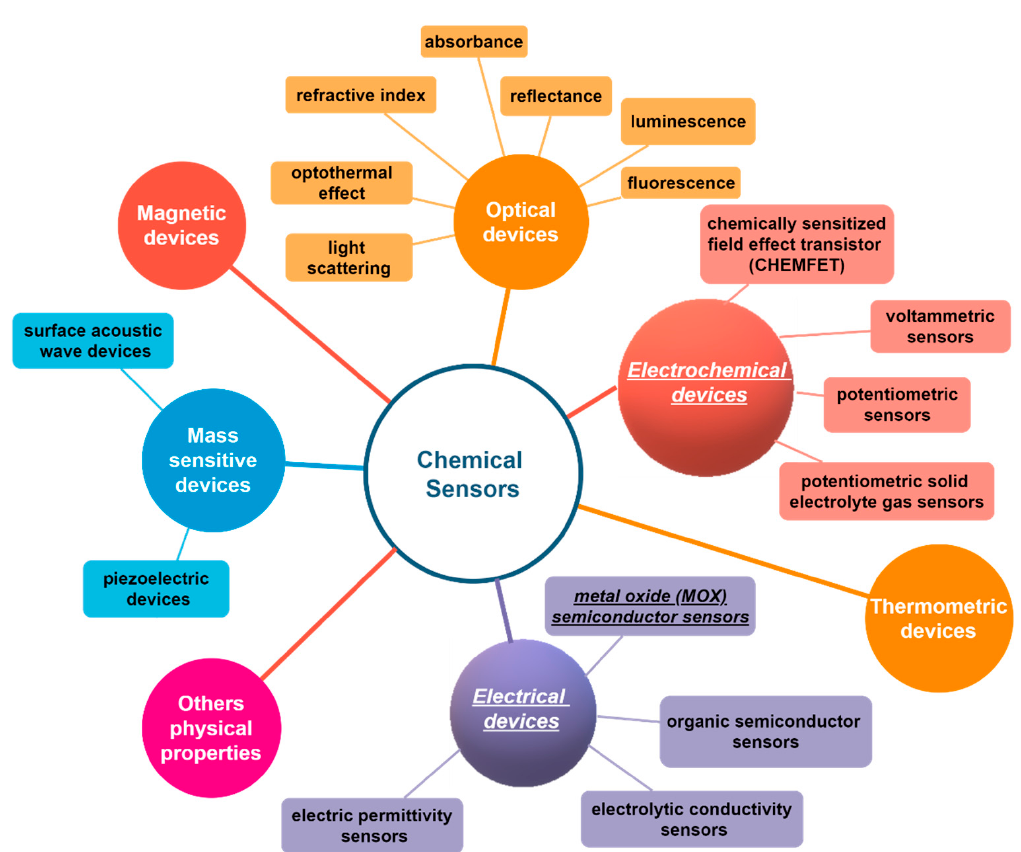
Figure 1. Scheme of the chemical sensors classification from International Union of Pure and Applied Chemistry (IUPAC) [1].